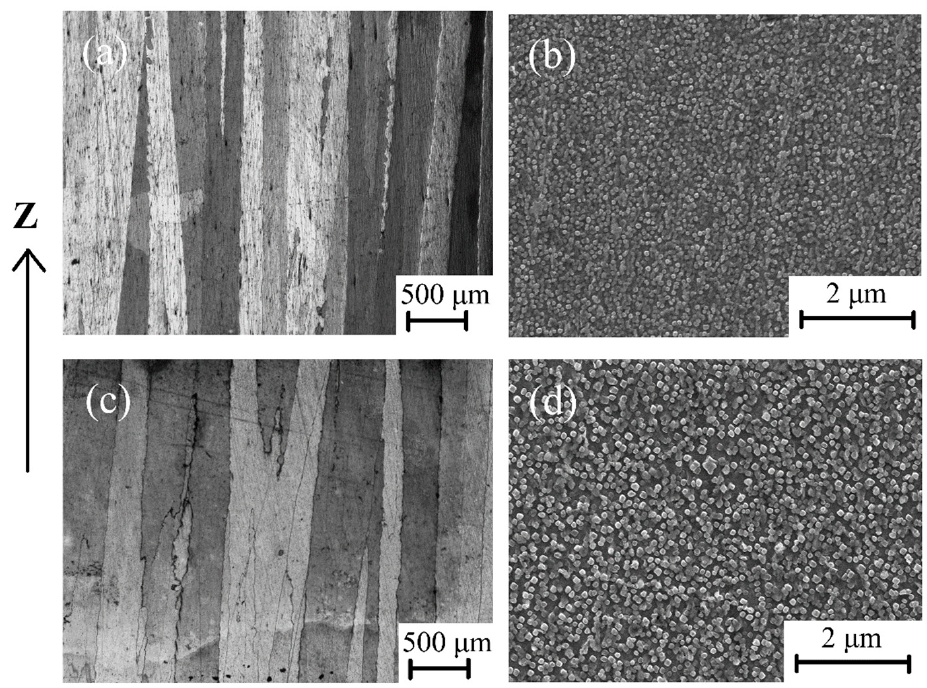
Figure 6. Optical micrographs in the X-Z plane of GH4099 samples fabricated by EBM deposited with: ( a ) GA; ( c ) PREP powder, and SEM micrographs of γ′ phase as-EBM GH4099 samples showing the morphology of γ′ precipitates: ( b ) GA; ( d )PREP.